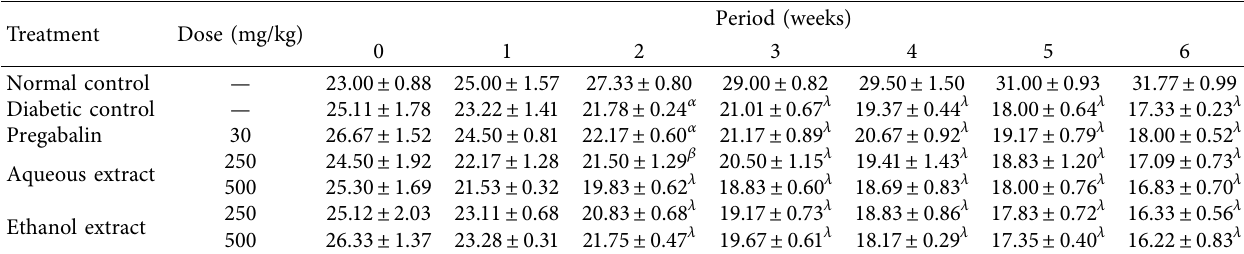
Table 2: Effects of the aqueous (AE) and ethanol (EE) extracts of Dissotis thollonii on body weight after injection of streptozotocin in mice. Treatment